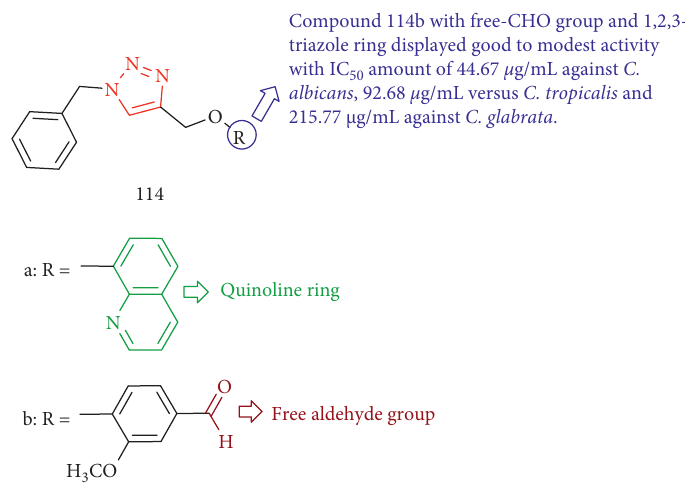
Figure 53: Chemical structure of novel 1,2,3-triazole derivatives.